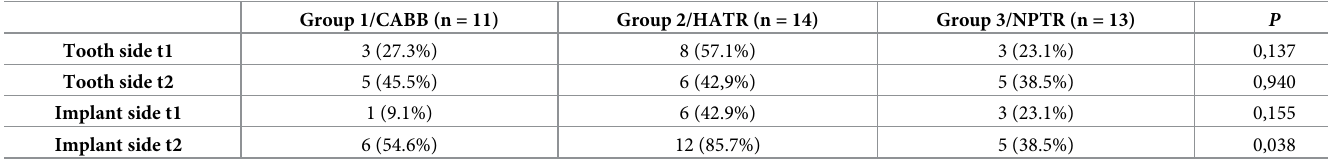
Table 1. Numbers and proportions of simultaneously Mycoplasma salivarium and Tannerella forsythia positive submucosal biofilm and peri-implant sulcus fluid